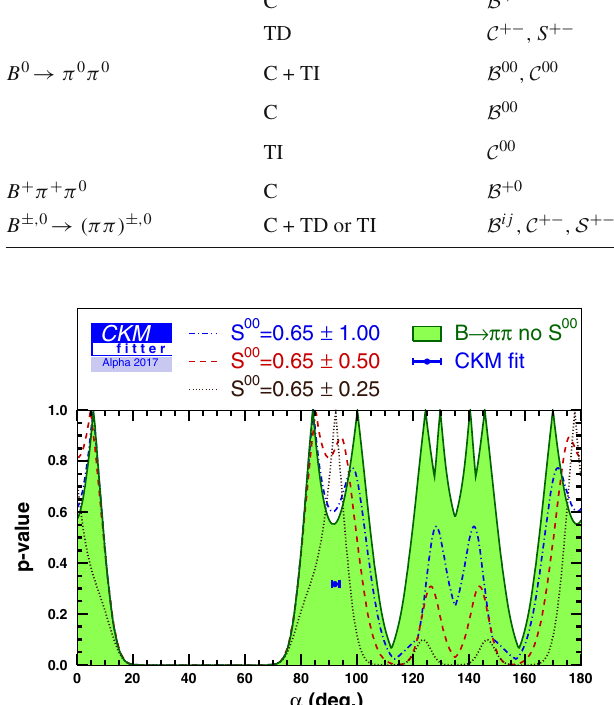
Fig. 41 Expected impact of the measurement of the time-dependent asymmetry S 00 on the α determination from the isospin analysis of the B → ππ system. The central value for S 00 corresponds to the best prediction from the SU ( 2 ) isospin